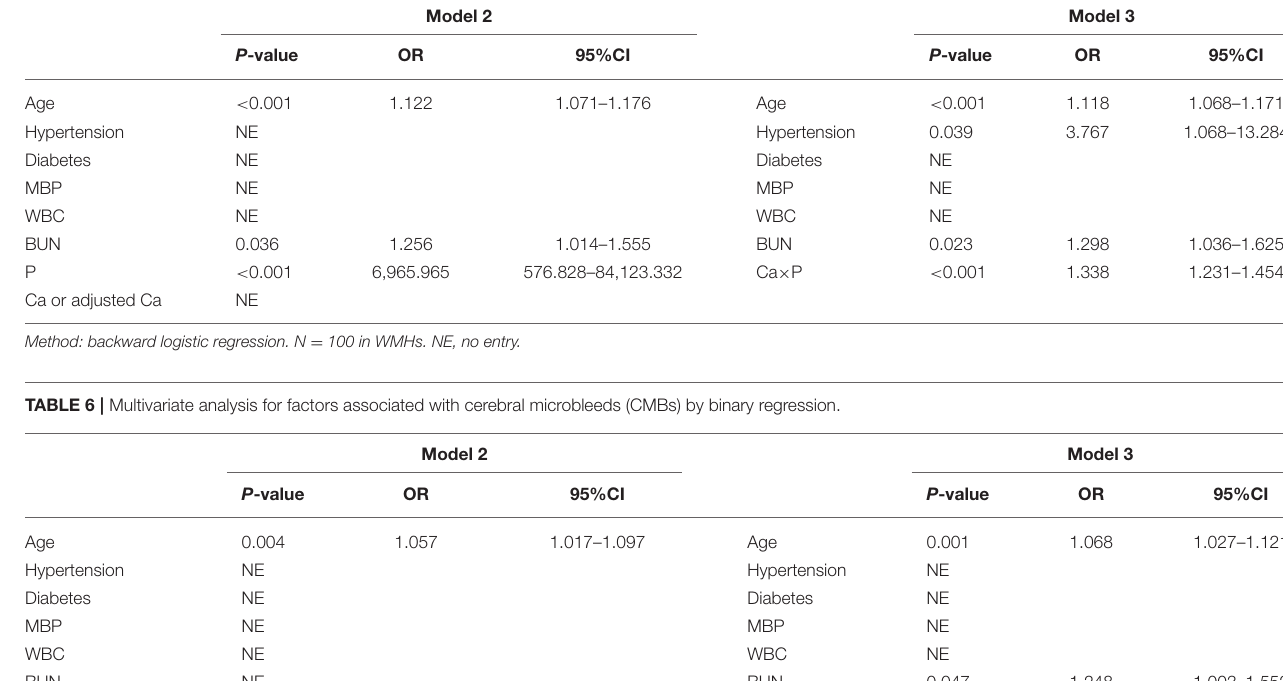
TABLE 5 | Multivariate analysis for factors associated with white matter hyperintensities (WMHs) by binary regression.